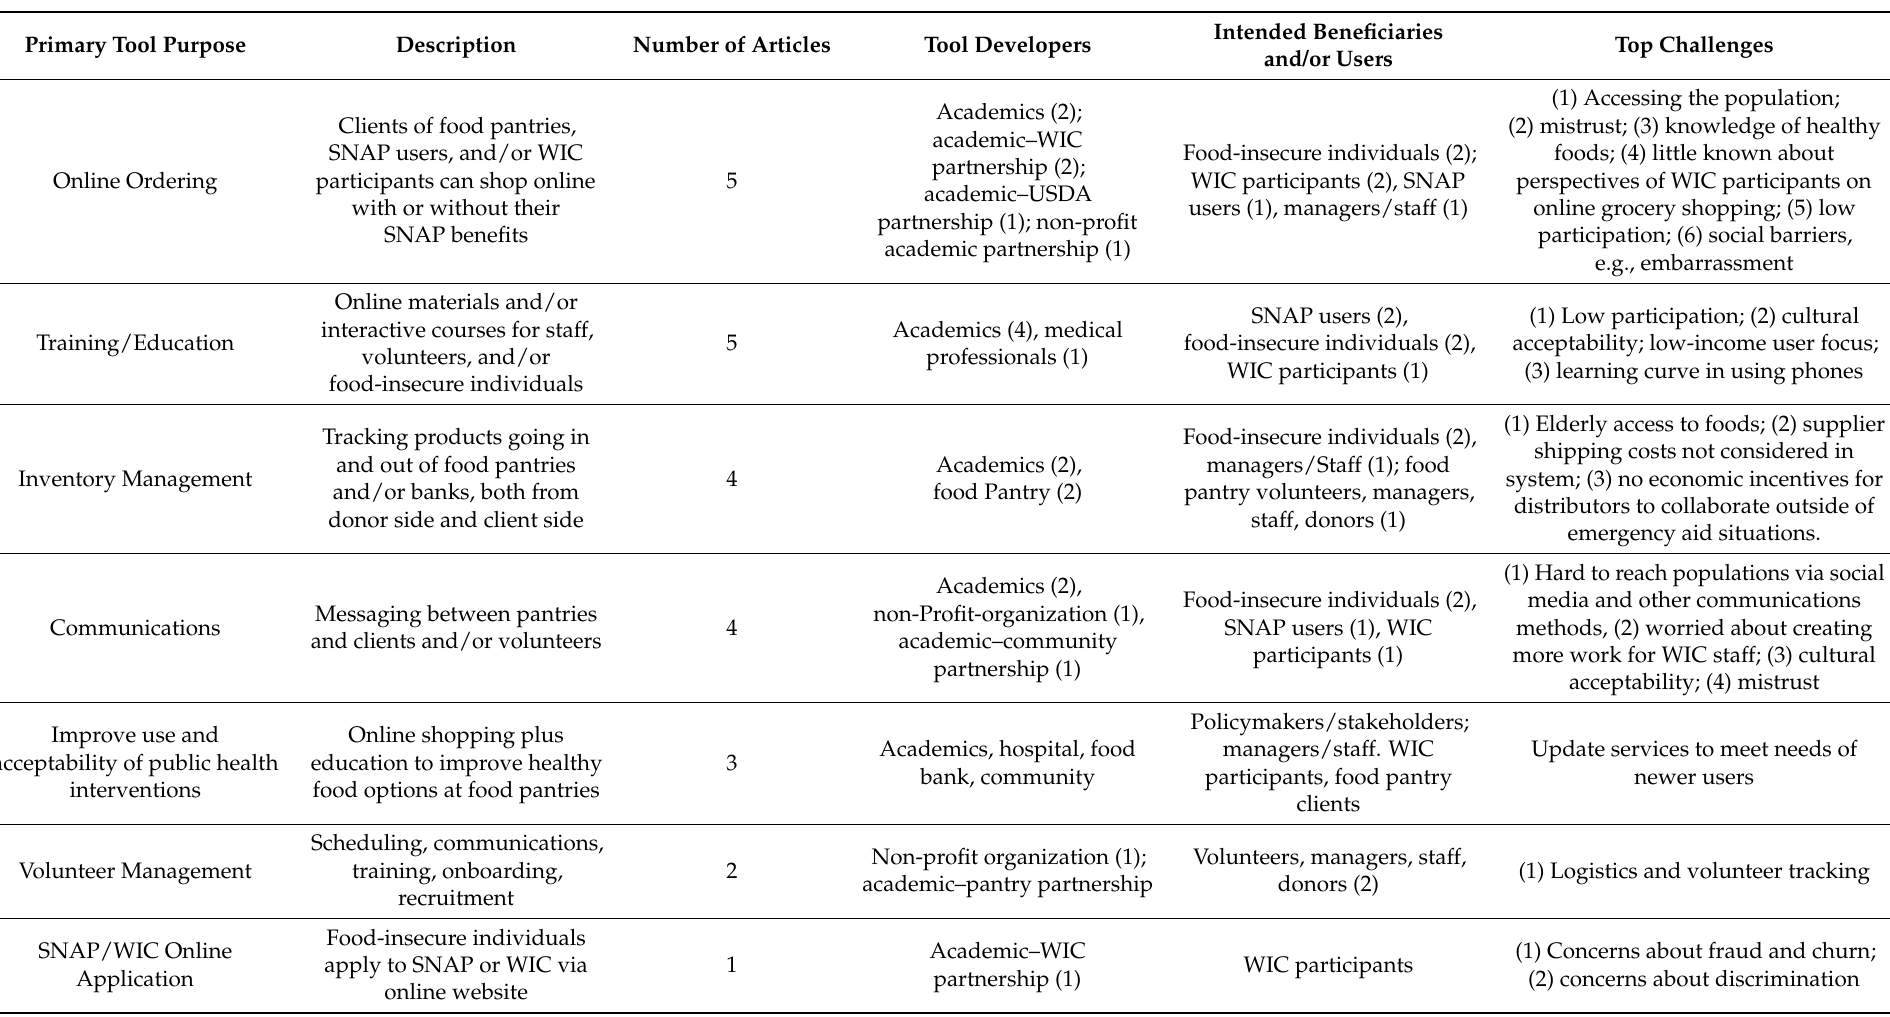
Table 6. Digital tools for food assistance peer-reviewed research